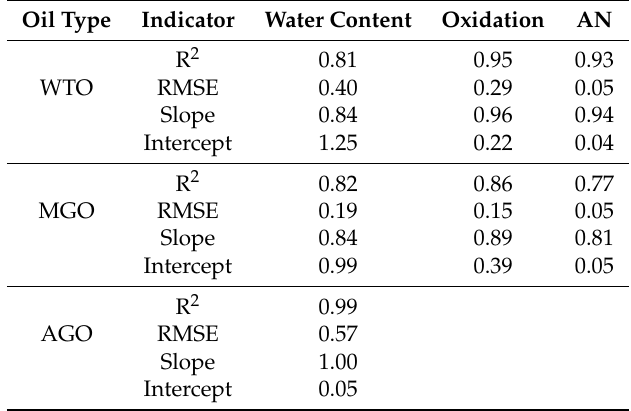
Table 3. Summary of the model validation results for all oil types and condition